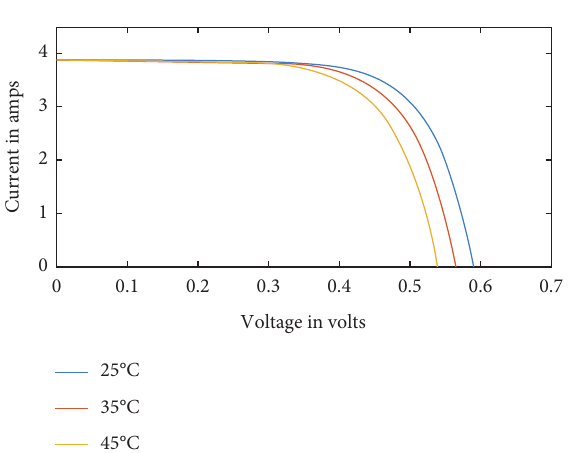
Figure 6: Simulated I-V plot of varying temperature of a solar cell.